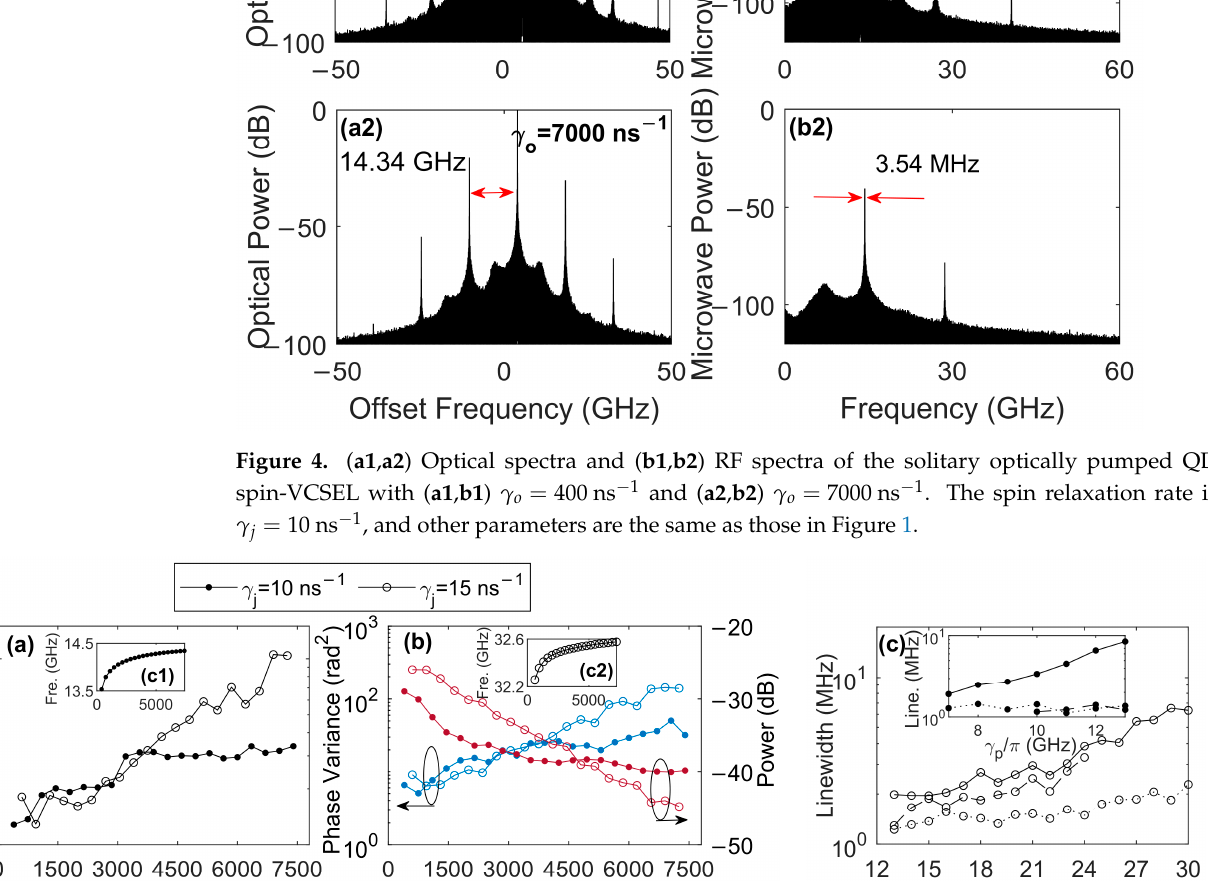
(cid:2879) 1 are symbolized by triangles. Both cases, represented by circles and triangles 𝛾 (cid:3043) = 30 π ns